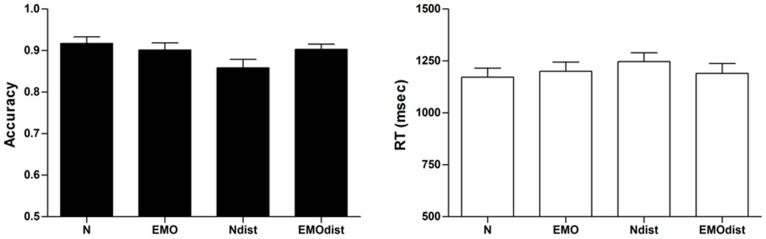
Accuracy and response times for behavioral performance in the working memory task, as a function of stimulus condition (N = pure neutral stimuli; EMO = pure emotional stimuli; Ndist = list with emotional standard stimuli and one unexpected neutral stimulus; EMOdist = list with neutral standard stimuli and one unexpected emotional stimulus).